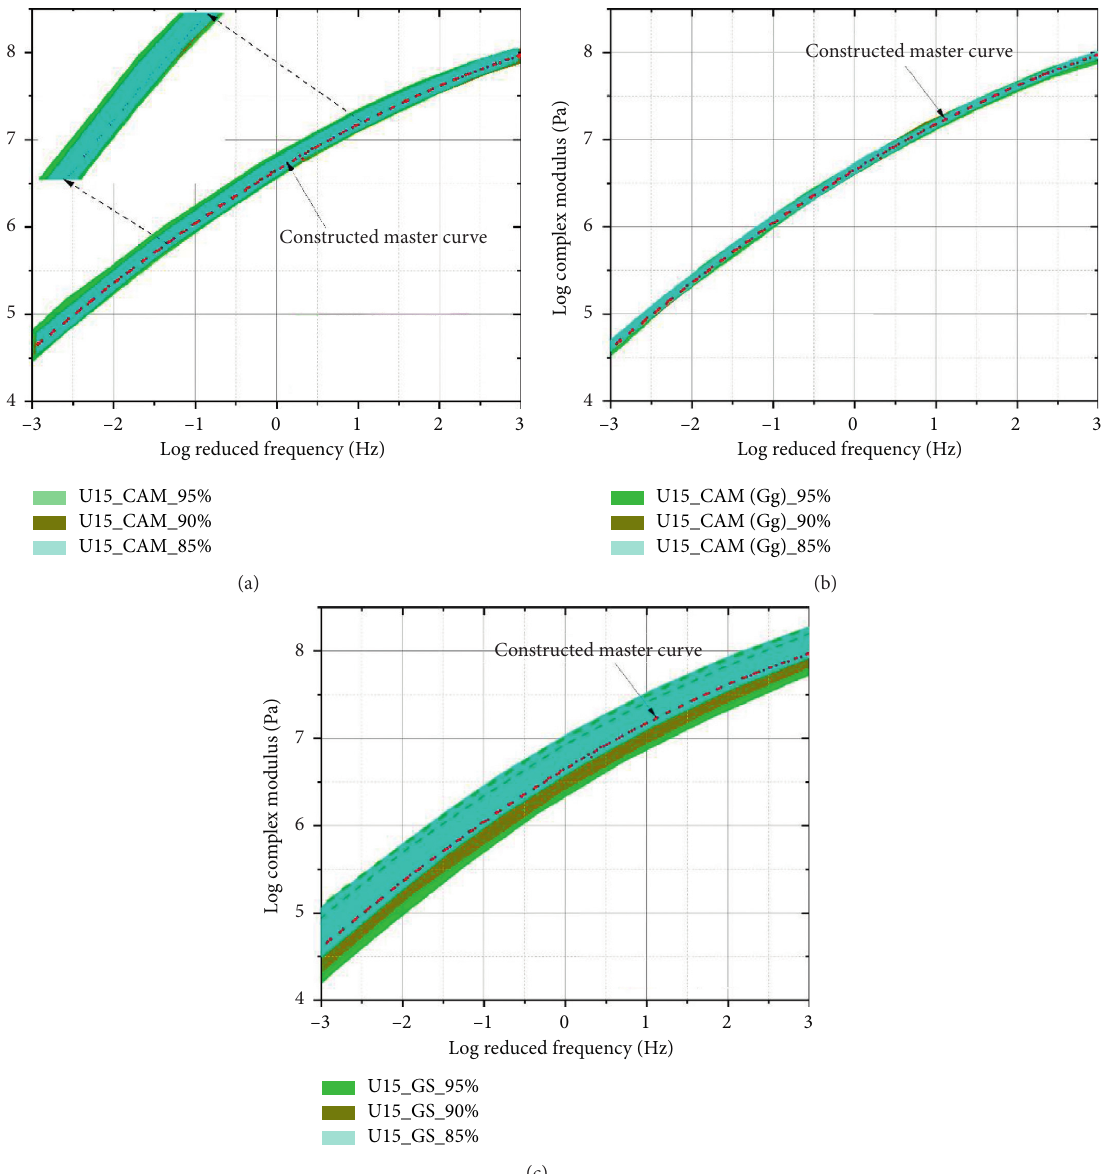
Figure 7: Master-curve bands constructed with different confidence levels. (a) CAM model. (b) CAM (Gg) model. (c) Generalized sigmoidal